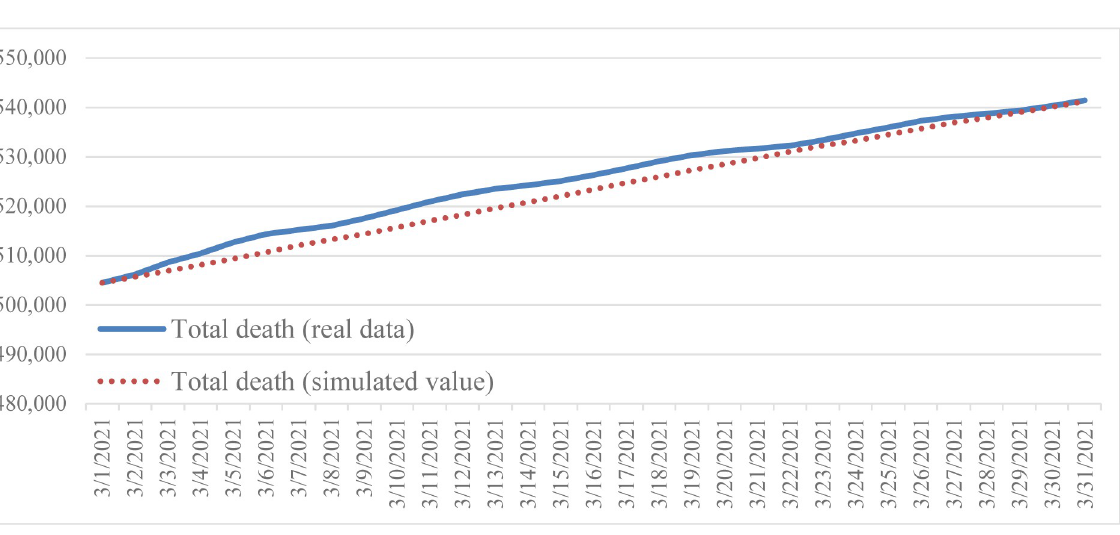
Fig 3. Comparison of reported total death and simulated total death.